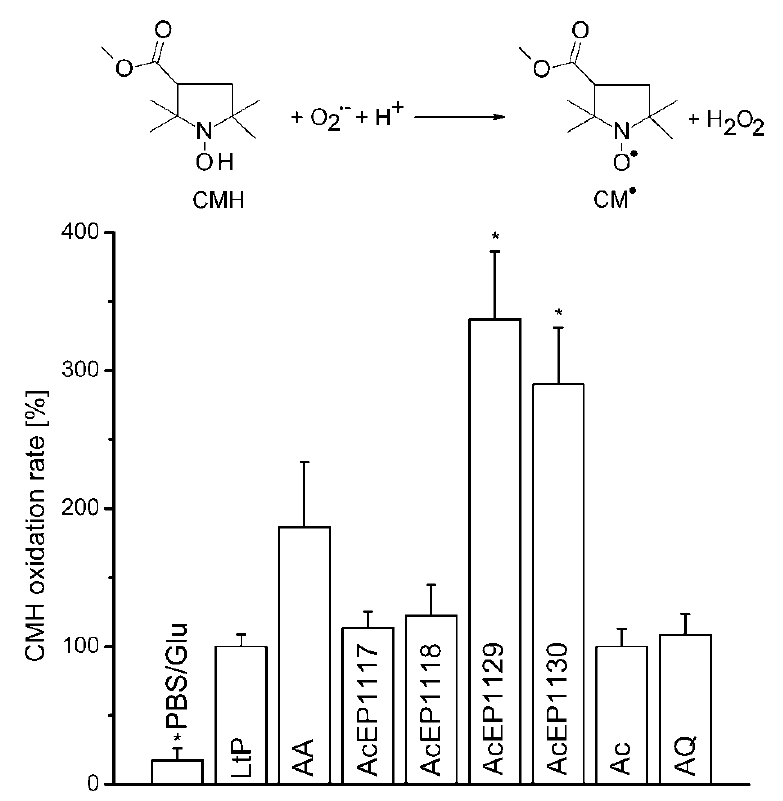
Figure 5. Rate of CMH oxidation by superoxide radicals derived from the activation of AcEPs in LtP. LtP (500 × 10 6 LtP/mL) suspended in PBS containing glucose (15 mM, PBS/Glu), DFO (100 µM), DTPA (25 µM), and CMH (400 µM) were incubated with 20 µM AA or 100 µM of AcEP1117, AcEP1118, AcEP1129, AcEP1130, Ac, or AQ at 25 °C for 5 min. Negative controls consisted of PBS/Glu or cell suspension containing CMH. Data were normalized against the untreated cells (LtP, 100%). Data represent mean ± SD ( n = 3), * indicates significant differences to the control sample (LtP) at the level of p < 0.05.